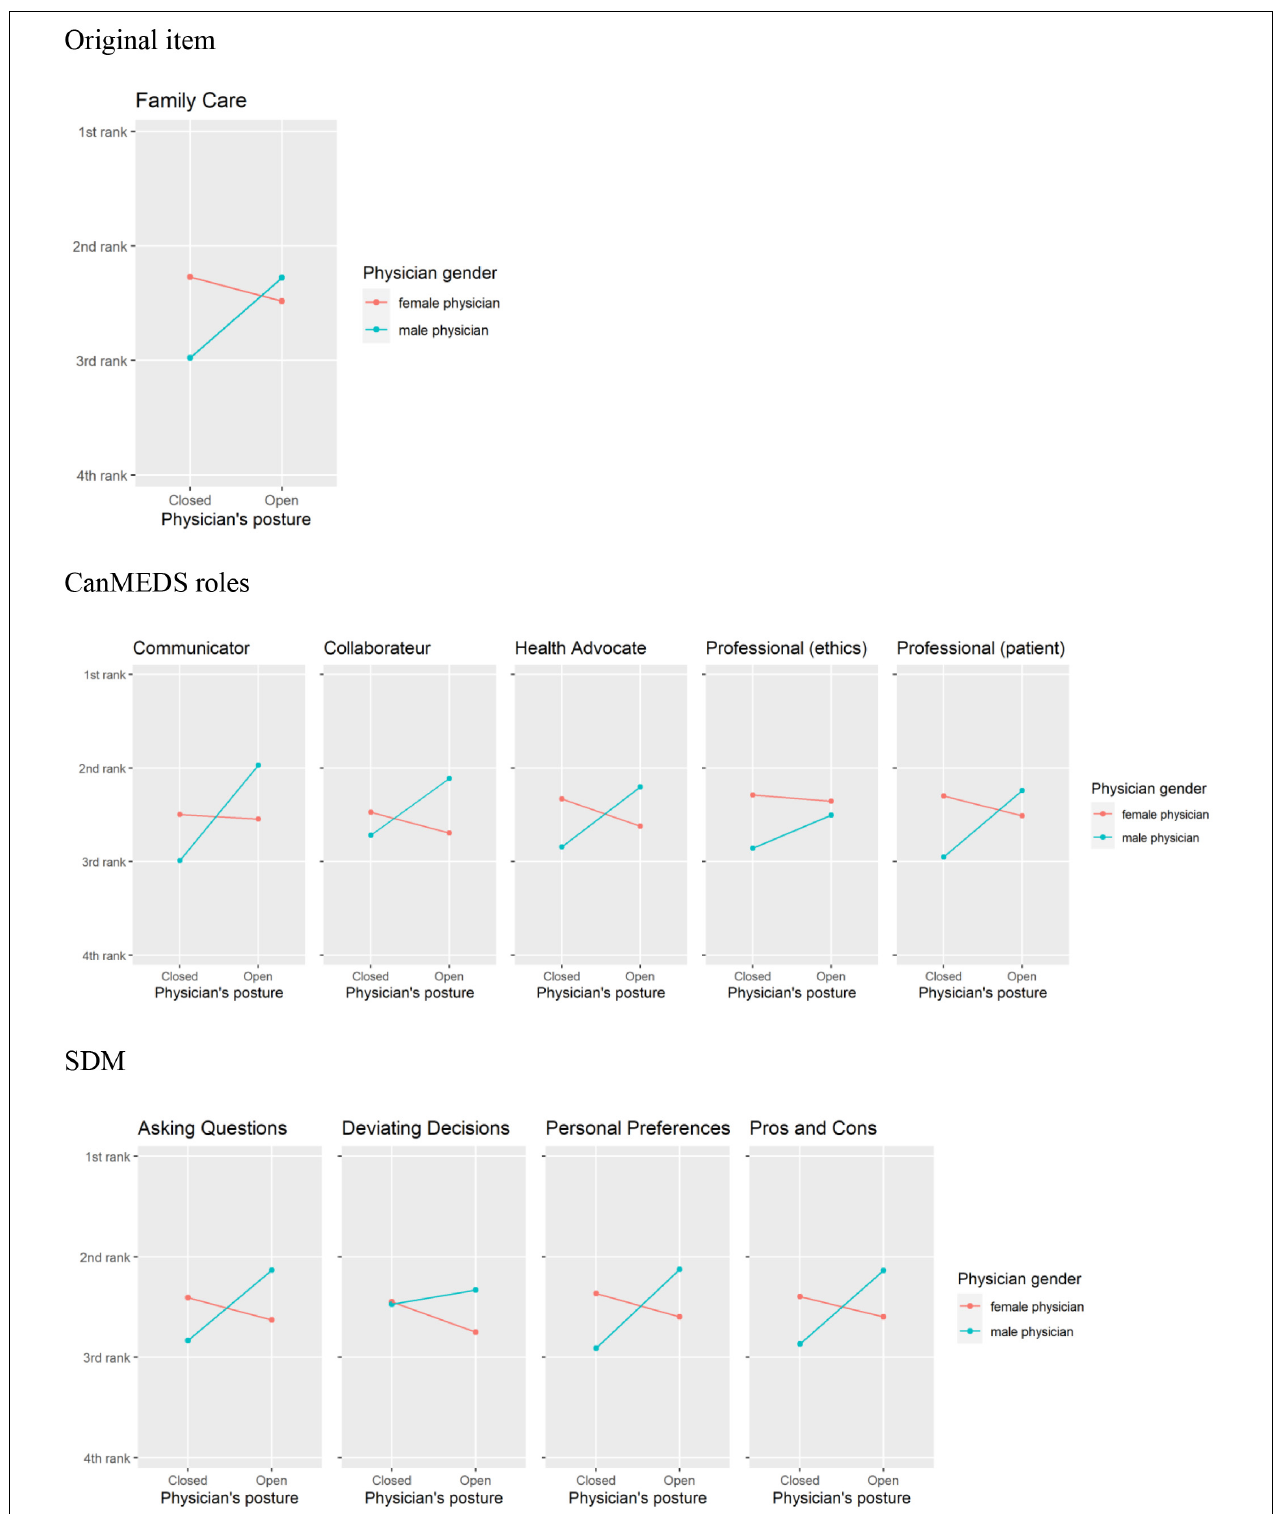
FIGURE 3 | Interaction overview of items, for which open and closed postures have a trend for an X-shaped Interaction for male and female physicians.